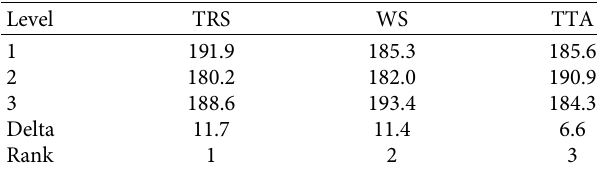
Table 7: Means response